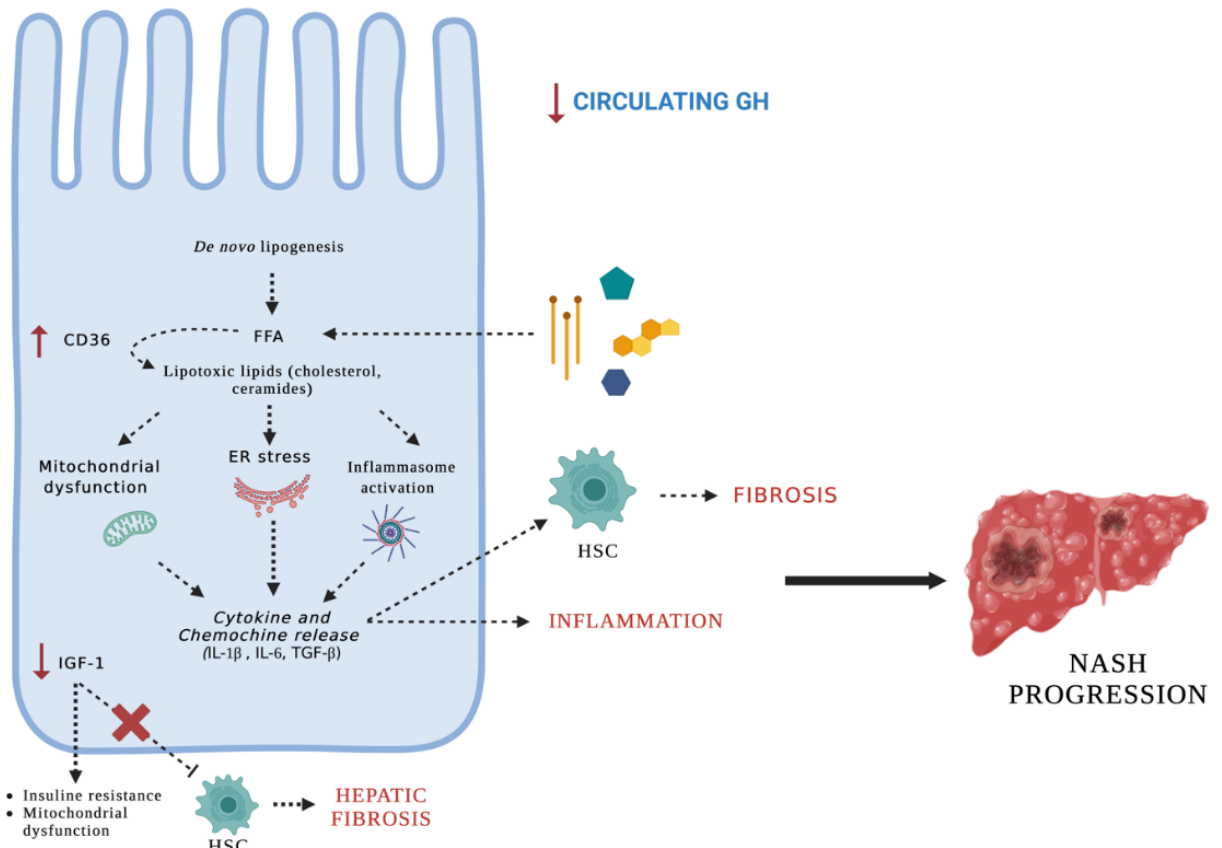
Figure 4. Effects of growth hormone deficiency on liver. Both hepatocyte lipotoxicity and immune- mediated inflammation are considered pivotal events in the pathogenesis of NASH. Growth hormone deficiency causes up-regulation of genes involved in de novo lipogenesis, such as CD36. Increased hepatic CD36 expression leads to higher lipogenesis, increased triglycerides (Tg) accumulation, and insulin resistance, favoring hepatic steatosis. Excess dietary fats and simple carbohydrate intake activate transcription factors that control de novo lipogenesis and mitochondrial function. Dysregulation of β oxidation induces endoplasmic reticulum (ER) stress, oxidative stress, and inflammasome activation. These events collectively lead to hepatic inflammation and fibrosis. A decrease in insulin-like growth factor-1 (IGF-1) results in insulin resistance and mitochondrial dysfunction that may further contribute to the development of NASH. Moreover, decreased IGF-1 may promote hepatic fibrosis, as IGF-1 directly inactivates hepatic stellate cells.